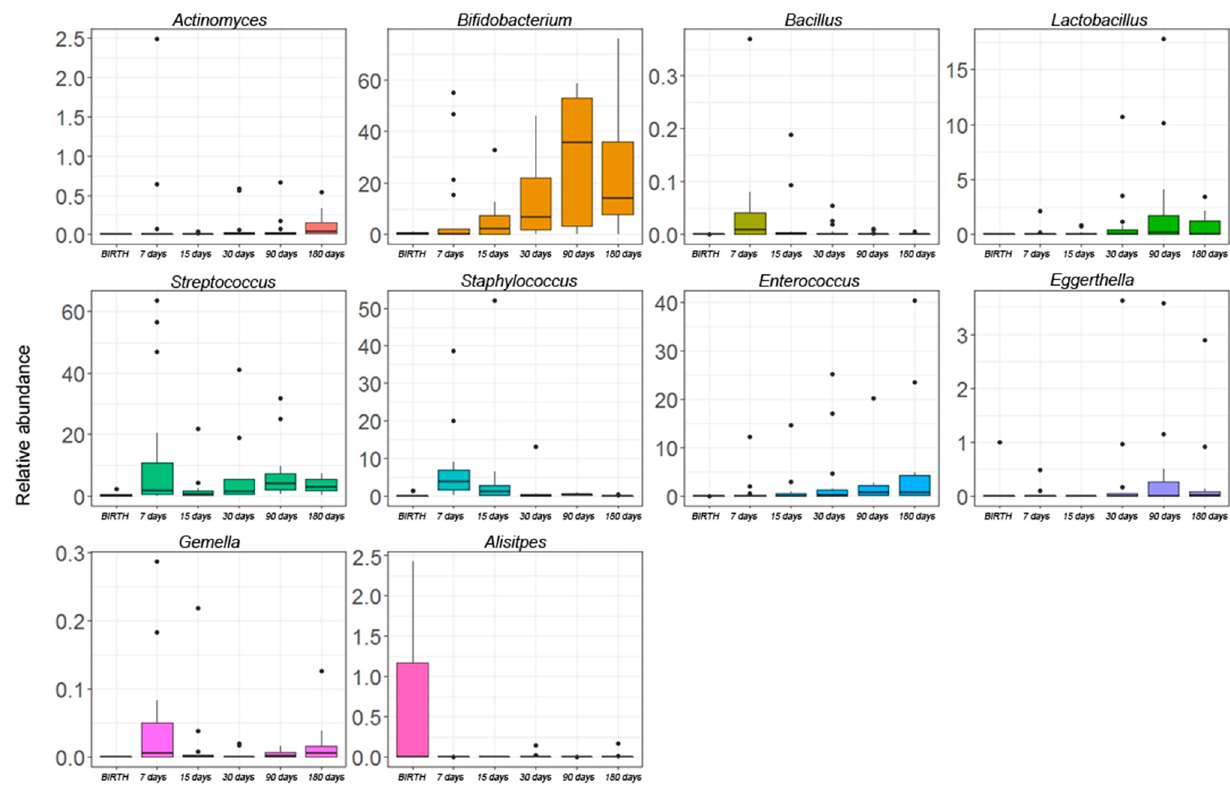
Figure 4. The Kruskal–Wallis test-based OTU distribution of the gut microbiota. The bar graphs represent the average distribution of the OTUs at the genus level in the gut microbiota during the first six months of infant’s age. Only statistically significant OTUs with p FDR < 0.05 are shown.